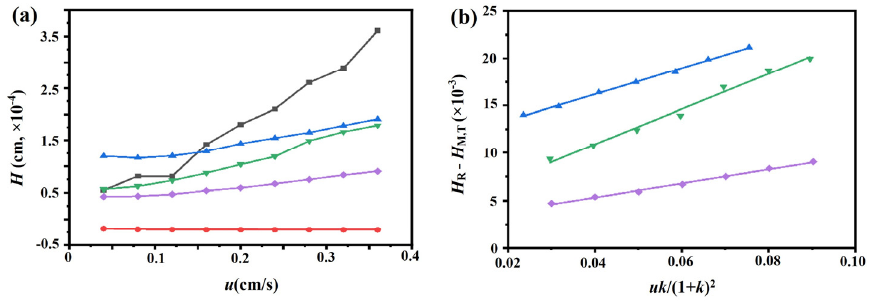
Figure 7. Typical peak pro fi les of the three drugs, sodium nitrate, and the theoretical non-retained substance on the M3R-immobilized column. The typical peak pro fi les of the three drugs, sodium nitrate, and the theoretical non-retained substance on the M3R-immobilized column by a multianalyte approach ( a ) and fi tt ing plots of ( H R − H M ) vs. ( uk )/(1 + k ) 2 for the binding of the three drugs to M3R ( b ). The blue triangle ( ▲ ) indicates atropine sulfate, the purple diamond ( ♦ ) represents pilocarpine, the green triangle ( ▼ ) is ( − )-scopolamine hydrochloride, the black square ( ■ ) refers to sodium nitrate, and the red circle ( ● ) represents the theoretical unretained substance.